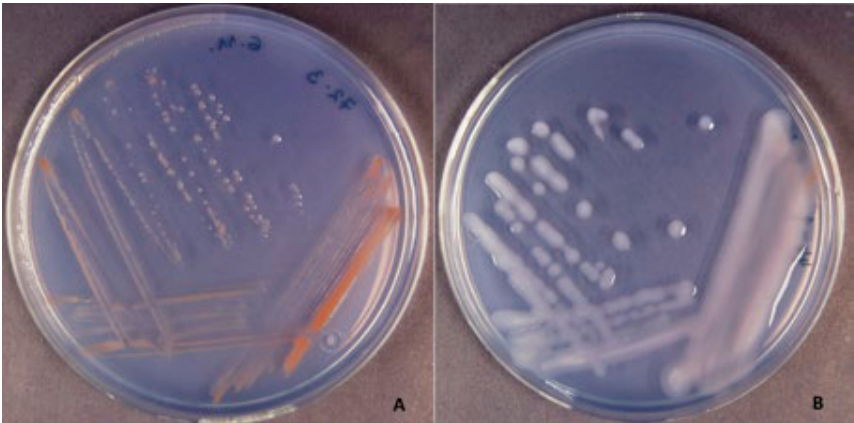
Figure 1. Colony morphologies of Agrobacterium tumefaciens genomic species G1 and G4 on 1A medium. (A) Orange-brown pigmentation of genomic species G1 (strain 72-3). (B) Lavender pigmentation and mucoid phenotype of genomic species G4 (strain 44-1). Cultures were incubated at 27°C for 4